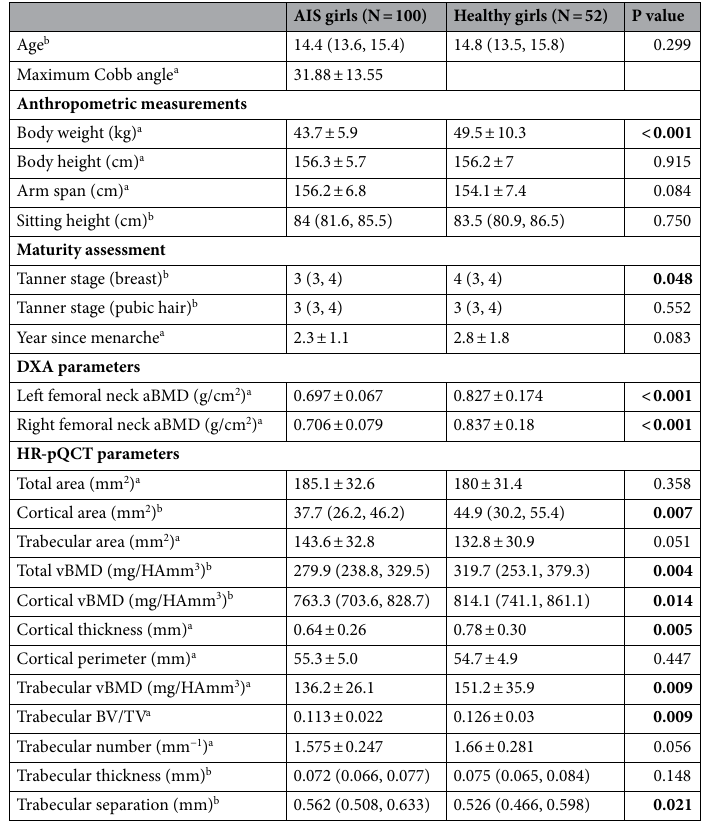
Table 2. Clinical and demographic characteristics of participants involved in validation cohort. a Normally distributed data were presented as mean ± standard deviation (SD) and independent samples t test was used. b Data that were not normally distributed were presented as median (lower quartile, upper quartile). Mann– Whitney U test was used. Bold text indicated p value <